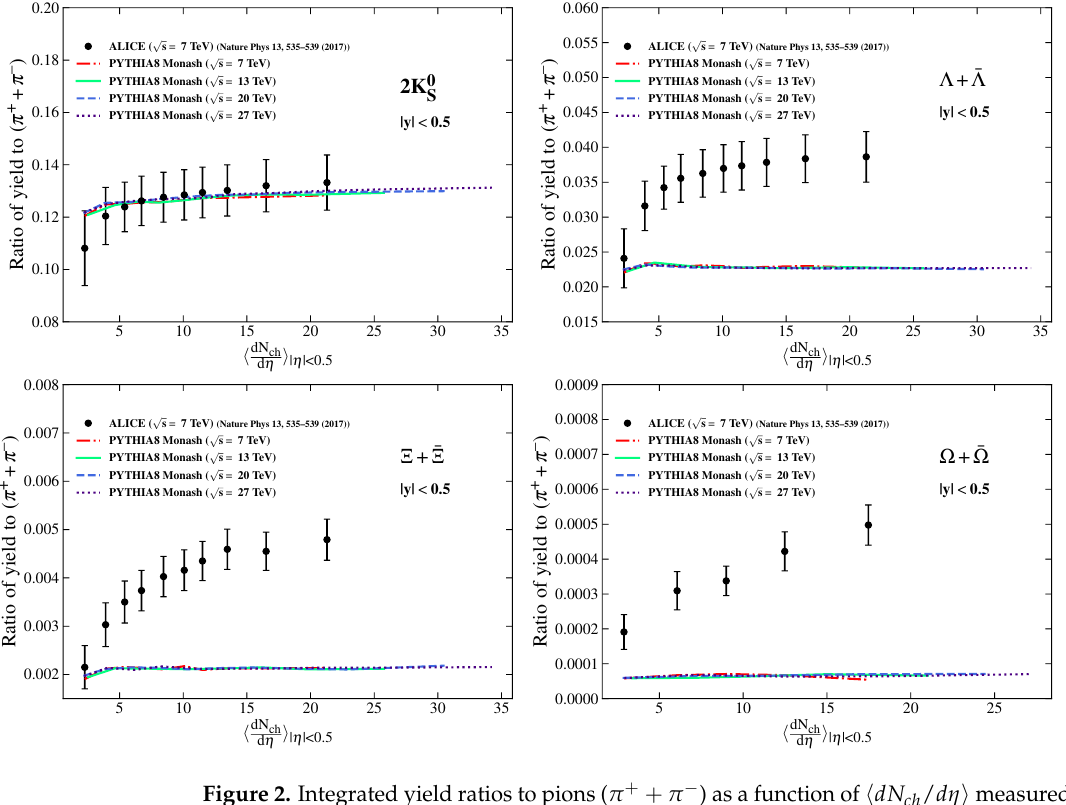
< 0.5 dN ch / d η y measured in (cid:104) (cid:105) | |